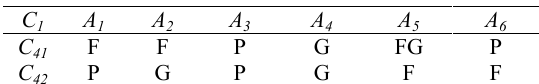
Table 6. Performance assessments of alternatives for Societal ( C 4 ).